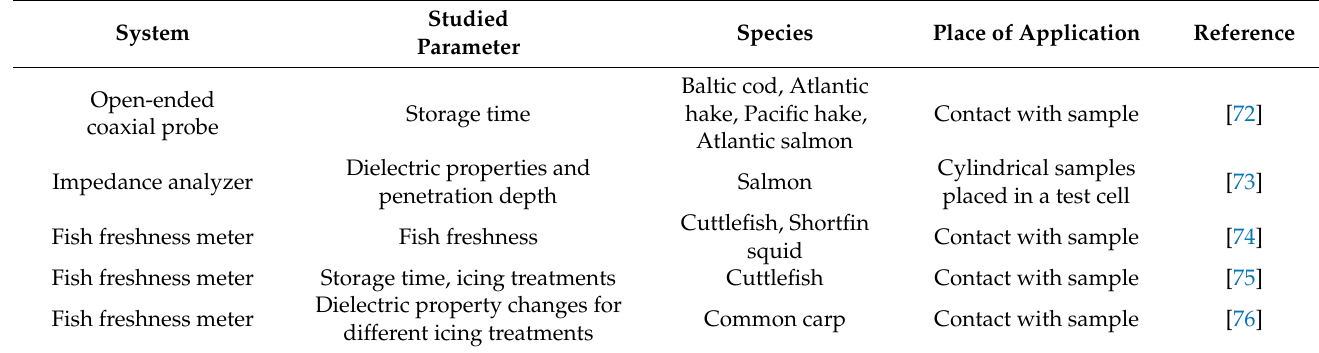
Table 3. Dielectric